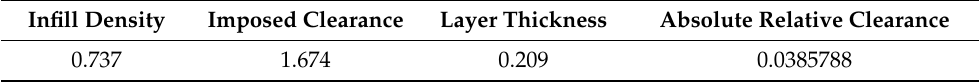
Table 4. The minimum value for absolute relative clearance obtained using GA.